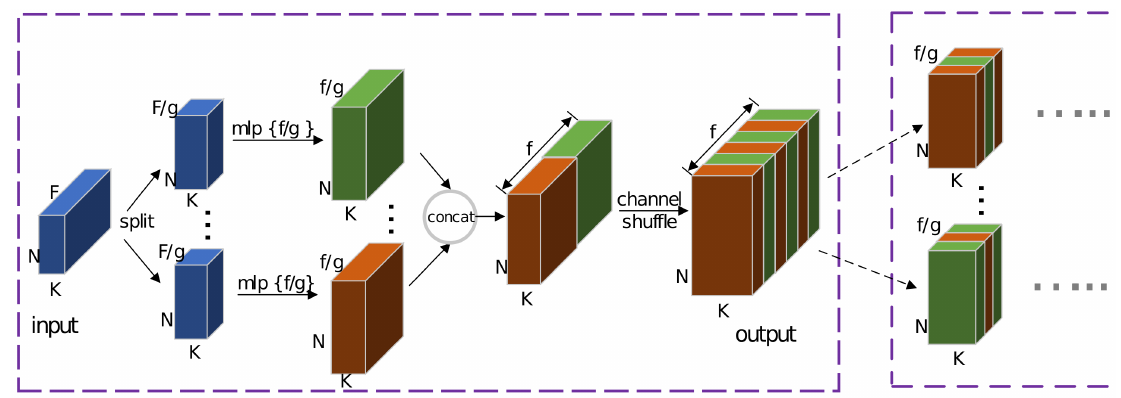
Figure 4. MLP Shuffled Group Convolution unit (SGC